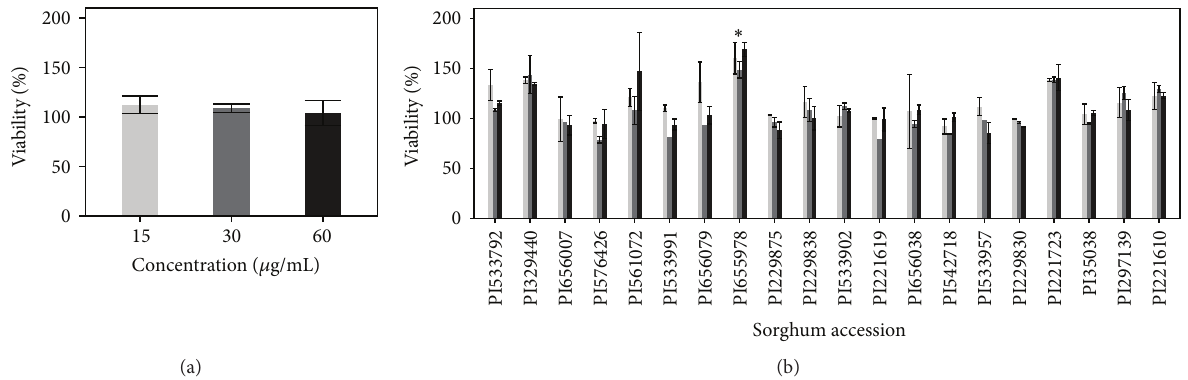
Figure 3: MTT cell viability assays of RAW 264.7 cells treated with sorghum bran extracts. Cells were seeded in 96-well plates, incubated overnight, and pretreated with sorghum bran extracts at concentrations of 60 𝜇 g/mL, 30 𝜇 g/mL, and 15 𝜇 g/mL for 1 hour before LPS stimulation (1 𝜇 g/mL) for 18 hours. Results are expressed as percentage of absorbance in extract-treated cells versus control cells (no extract added). (a) Mean viability value of all accessions and (b) value of each of the twenty accessions at extract concentrations of 15 𝜇 g/mL (light gray), 30 𝜇 g/mL (gray), and 60 𝜇 g/mL (dark gray). Error bars represent the means of triplicate experiments ± SD. Accessions are ordered from lowest total phenols to highest ones. ∗ 𝑃 < 0.05